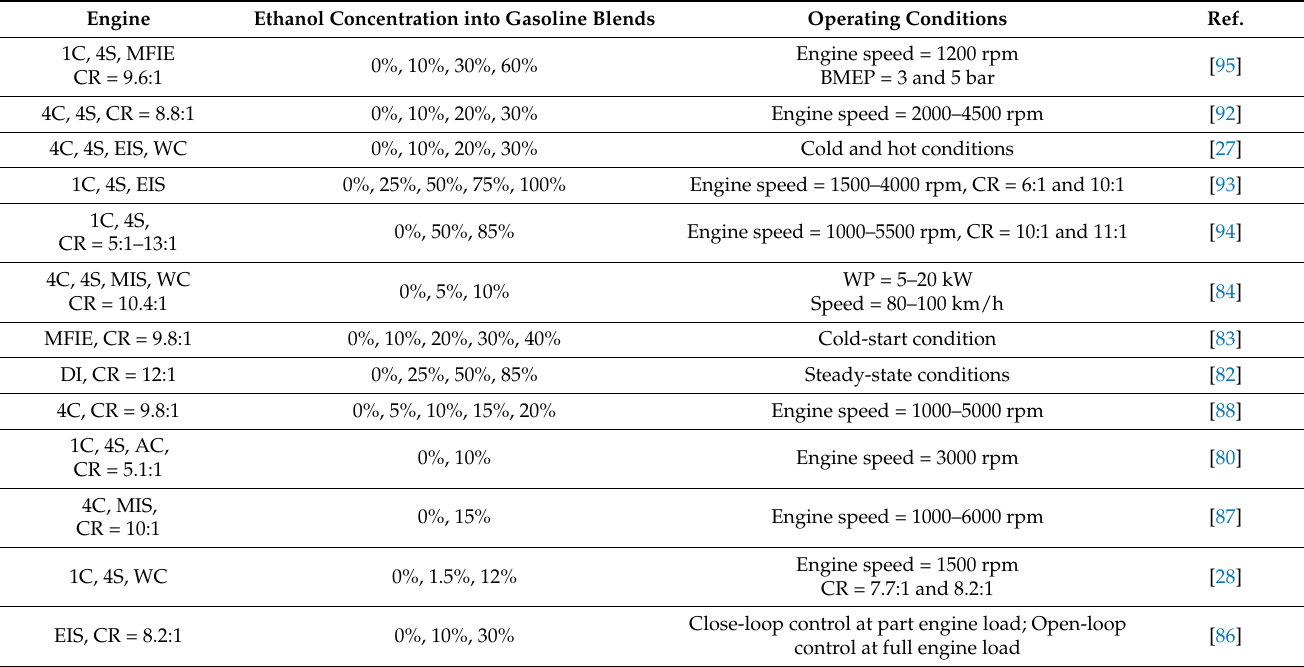
Table 2. Main experimental tests concerning the effect of ethanol concentration and operating conditions on HC and CO emissions using gasoline/ethanol blends in SI